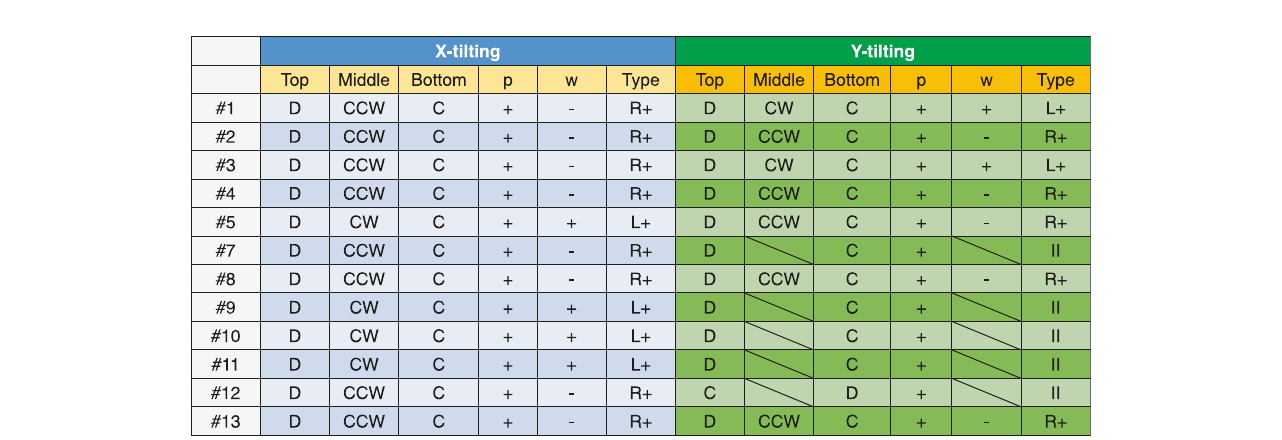
D divergent, C convergent, CW clockwise, CCW counterclockwise; L+ left-handed,type I bubblewith positive polarity, R+ right-handed, typeI bubble with positive polarity; L- left-handed,type I bubblewith negative polarity, R- right-handed, typeI bubble with negative polarity, II type-II